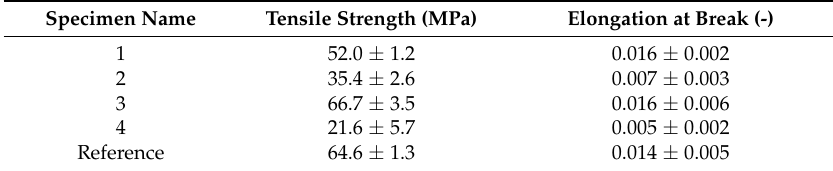
Table 16. Averaged tensile strength and elongation at break of the stress-strain behavior of the internal pressure tests for the samples influenced by the injection molding parameters.